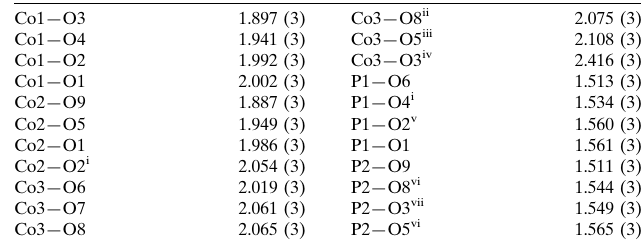
Selected bond lengths (A˚ ).